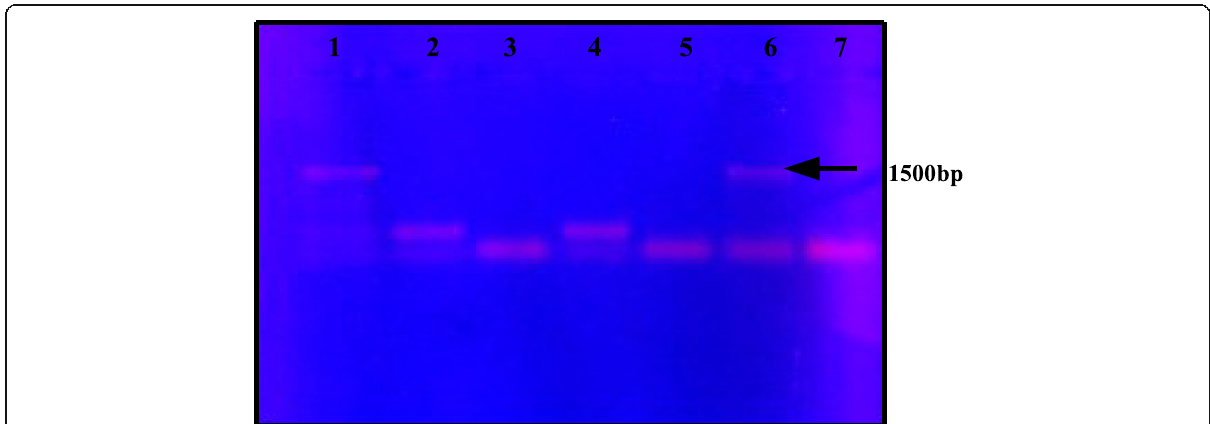
Fig. 3 Screening of recombinants by colony PCR on 1% agarose gel. Lane 1, positive control (amplicon from genomic DNA); lane 2-6, colony PCR